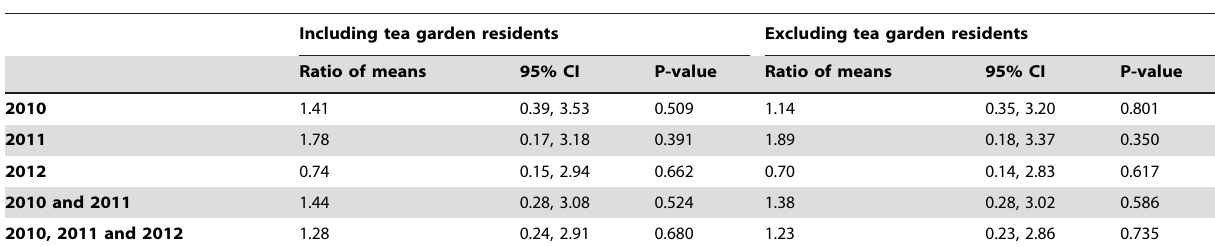
Table 4. Evaluation of the effect of participatory women’s groups on postpartum psychological